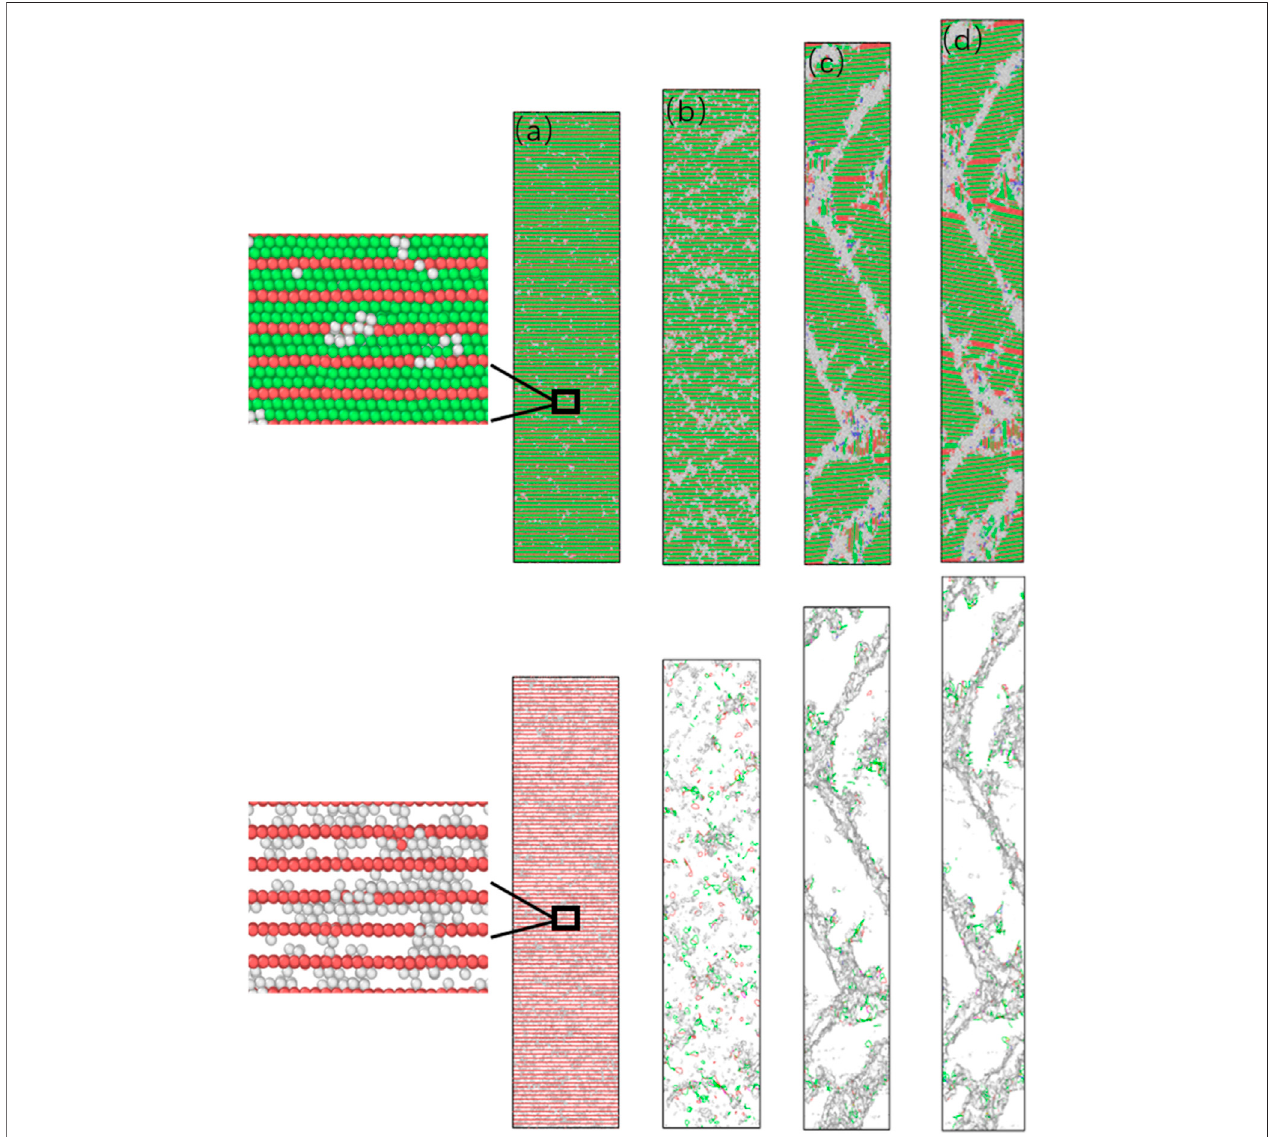
FIGURE 11 | The microstructure of nt-HEAs ( λ = 0.61 nm) under different strains (A) 2.6%, (B) 3%, (C) 10%, (D) 15%.